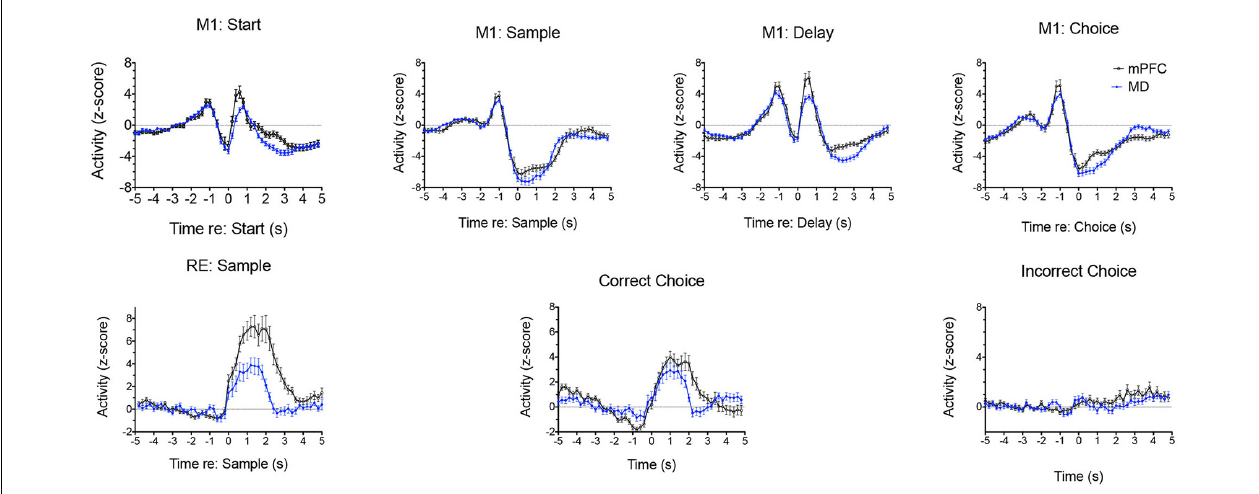
FIGURE 12 | Normalized population PETHs comparing the two most common responses in mediodorsal thalamus (MD) and medial prefrontal cortex (mPFC). Movement 1 (M1) responses aligned with the start, sample, delay, and choice lever presses are based on all samples observed in MD ( n = 91) and mPFC ( n = 97). Reinforcement excitation (RE) responses aligned with reinforced sample and correct choice and unreinforced incorrect choice responses are based on all examples observed in MD ( n = 47) and mPFC ( n = 63). Error bars represent the standard error of the mean. Data are replotted from Miller et al.